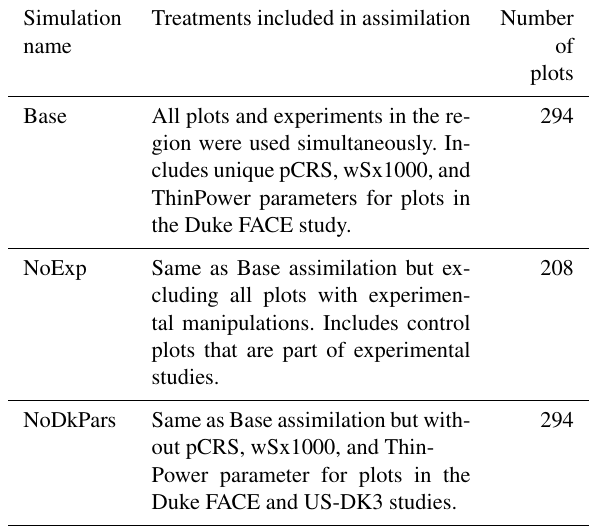
Table 4. Description of the different data assimilation approaches